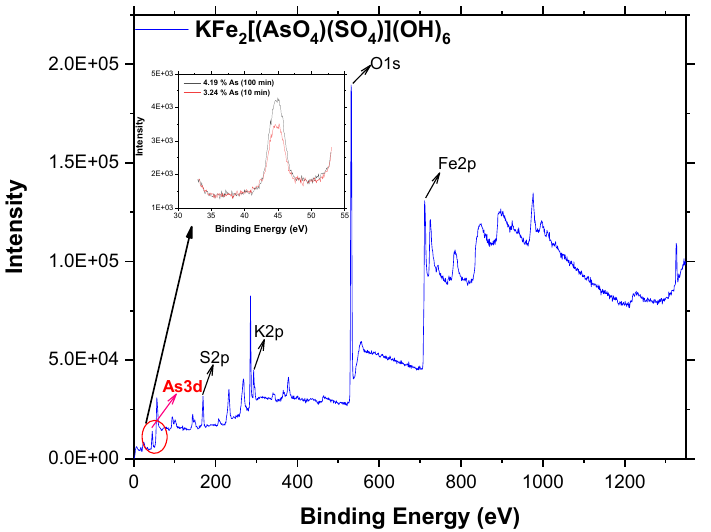
Figure 9. XPS spectra and contents of As(V) at 10 and 100 min after incorporation into jarosite structure.